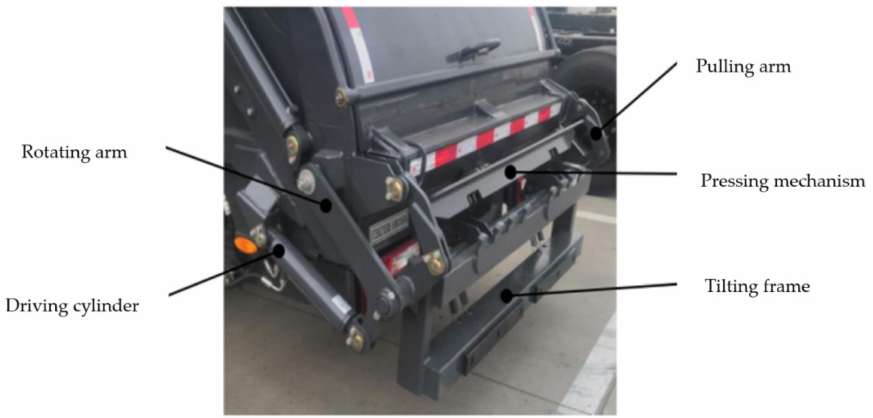
Figure 14. Turning mechanism.